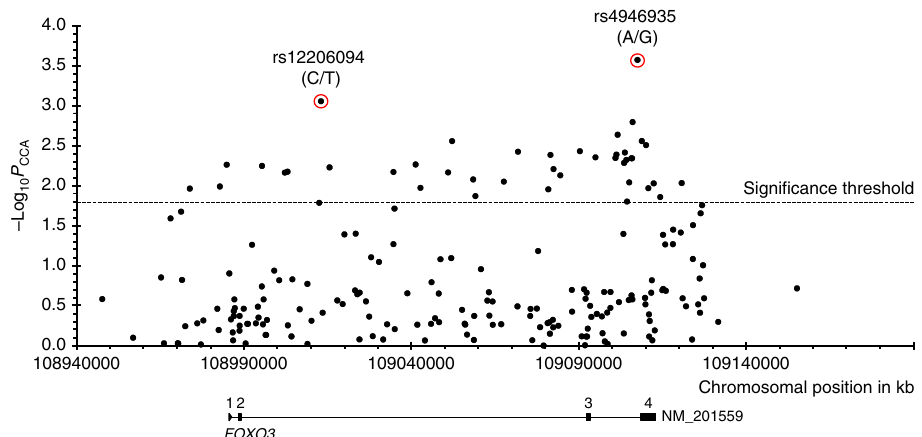
Fig. 1 Association plot shows all 205 SNVs tested in the FOXO3 gene region on chromosome 6 (hg18). The two SNVs with the best P values are indicated (red circles). The four exons are shown in the gene model. Number of individuals: 594 German long-lived individuals ( ≥ 100 years) and 918 controls (60 – 75 years). P CCA , allelic P values, determined in a case – control association study by chi-squared test with one degree of freedom; − log 10 P CCA , negative decadic logarithm of allelic P values